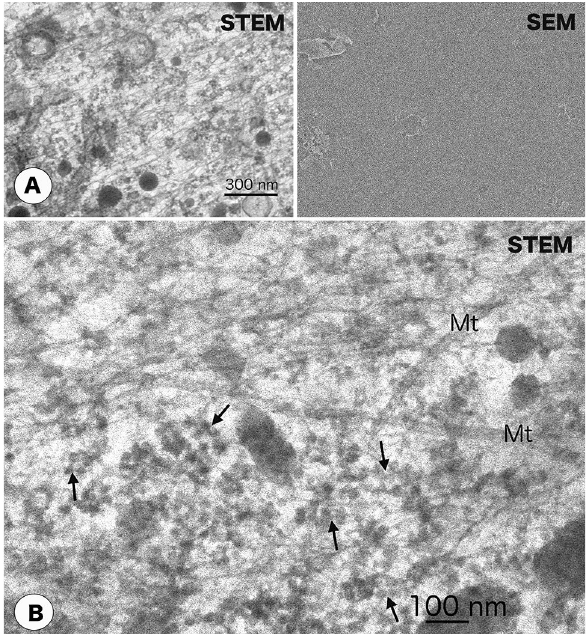
Figure 5. Cryo-electron micrographs of partially unroofed cells. ( A ) Simultaneous measurement by STEM and SEM modes revealed cytoskeletons, ribosomes, and the endoplasmic reticulum. In partially unroofed cells, the cell membrane was removed, but many organelles remained intact. The total thickness of the cell was sufficiently reduced by unroofing so that STEM images could be observed with little ice sublimation. The unroofed cell was completely embedded in ice, as shown by the flatness of SEM image. ( B ) Magnified cryo-STEM micrograph of the same sample shown in Figure ( A ). Poly-ribosomal-chains (arrows) and microtubules (Mt) are clearly observed. Ribosomes are often interconnected by extremely thin threads to form a ribosome chain. Because these structures are observed to overlap with other filaments and membrane structures, this unroofed cell appears to be a little bit